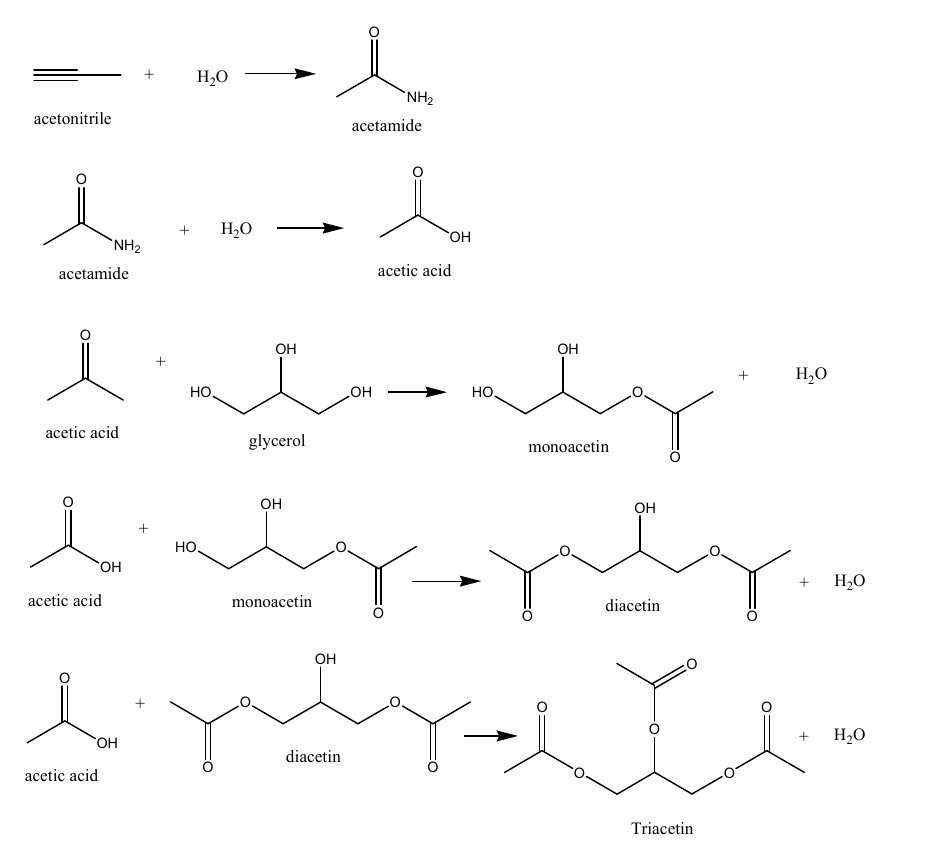
1730 cm −1 when using acetonitrile as the dehydrating agent indicates that this reaction fa- vours the formation of 4-HMO (Figure 6). This is in line with GC-MS data which showed that in the presence of acetonitrile 4-HMO was produced in quantities two- and three- times greater than with benzonitrile and adiponitrile respectively (Table S2).